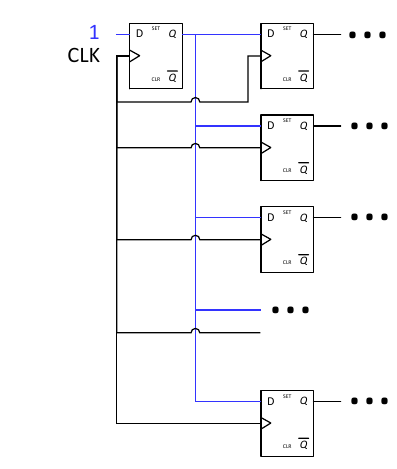
selected input (either all 1s or all 0s) and then stopping the clock signal of the chip and keeping all IO signals constant. The result of those measurements, presented as